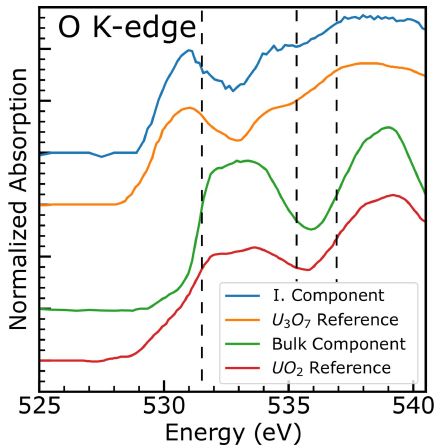
Figure 3 Comparison of the two component spectra obtained by modified non- negative matrix factorization (interfacial in blue and bulk in green) with reference spectra from Conradson et al. (2013) (U 3 O 7 in orange and UO 2 in red). Spectra are offset for clarity. The isosbestic points at 531.5, 535.3 and 536.9 eV as determined by k -means cluster analysis are shown as dotted